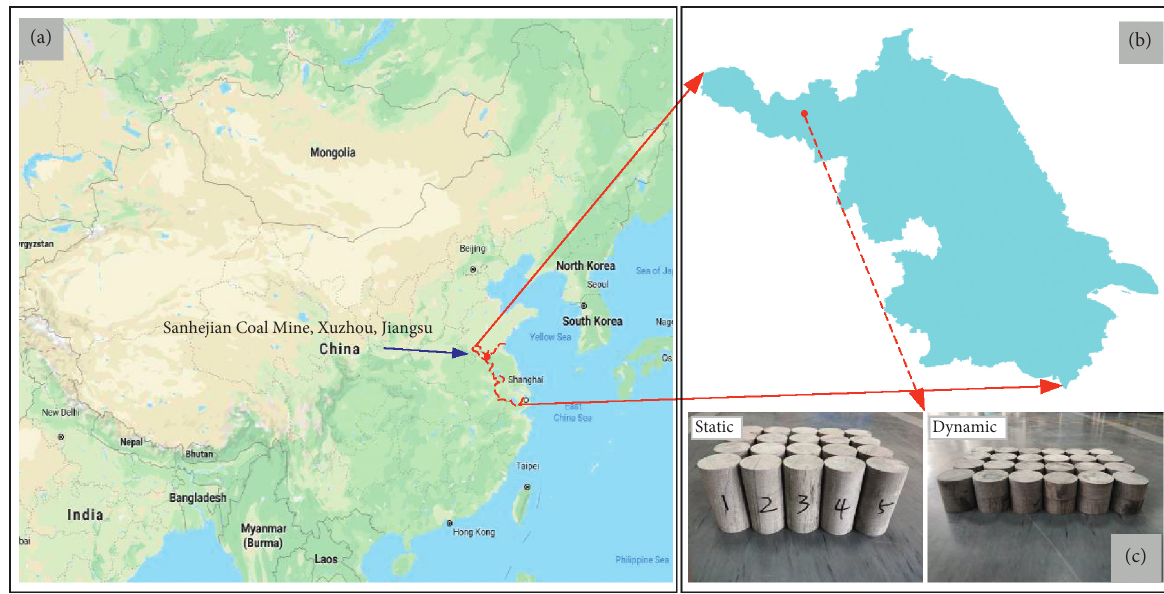
Figure 1: Location of the Jiangsu province from where the sandstone samples were obtained. (a) Location in China. (b) Detailed map of Jiangsu province. (c) The samples for static and dynamic tests; red point: rough location of Sanhejian Coal Mine.